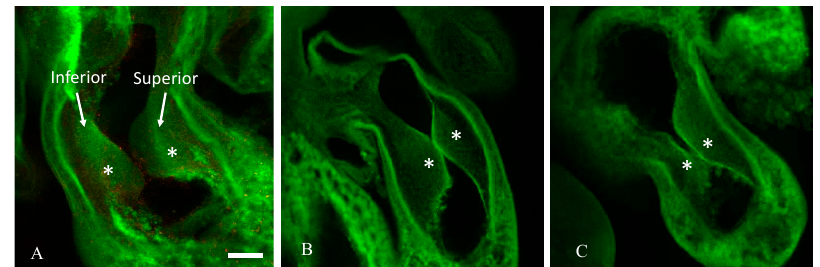
Figure 2. Hyperglycemia induces asymmetric endocardial OFT cushions at Hamburger–Hamilton stage 24 (HH24). Representative confocal images of a slice of the OFT cushions taken in the sagittal plane cushions labeled, and asterisks marking the two endocardial cushions from a representative vehicle control ( A ), an osmotic control ( B ), and a D -glucose-treated embryo ( C ). Scale bar = 100 µm, equivalent across images.